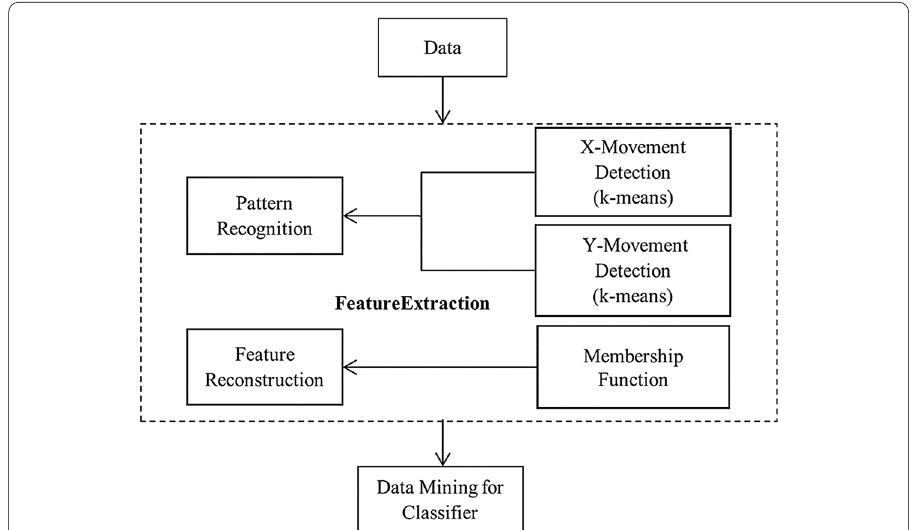
Fig. 2 Block diagram of the proposed